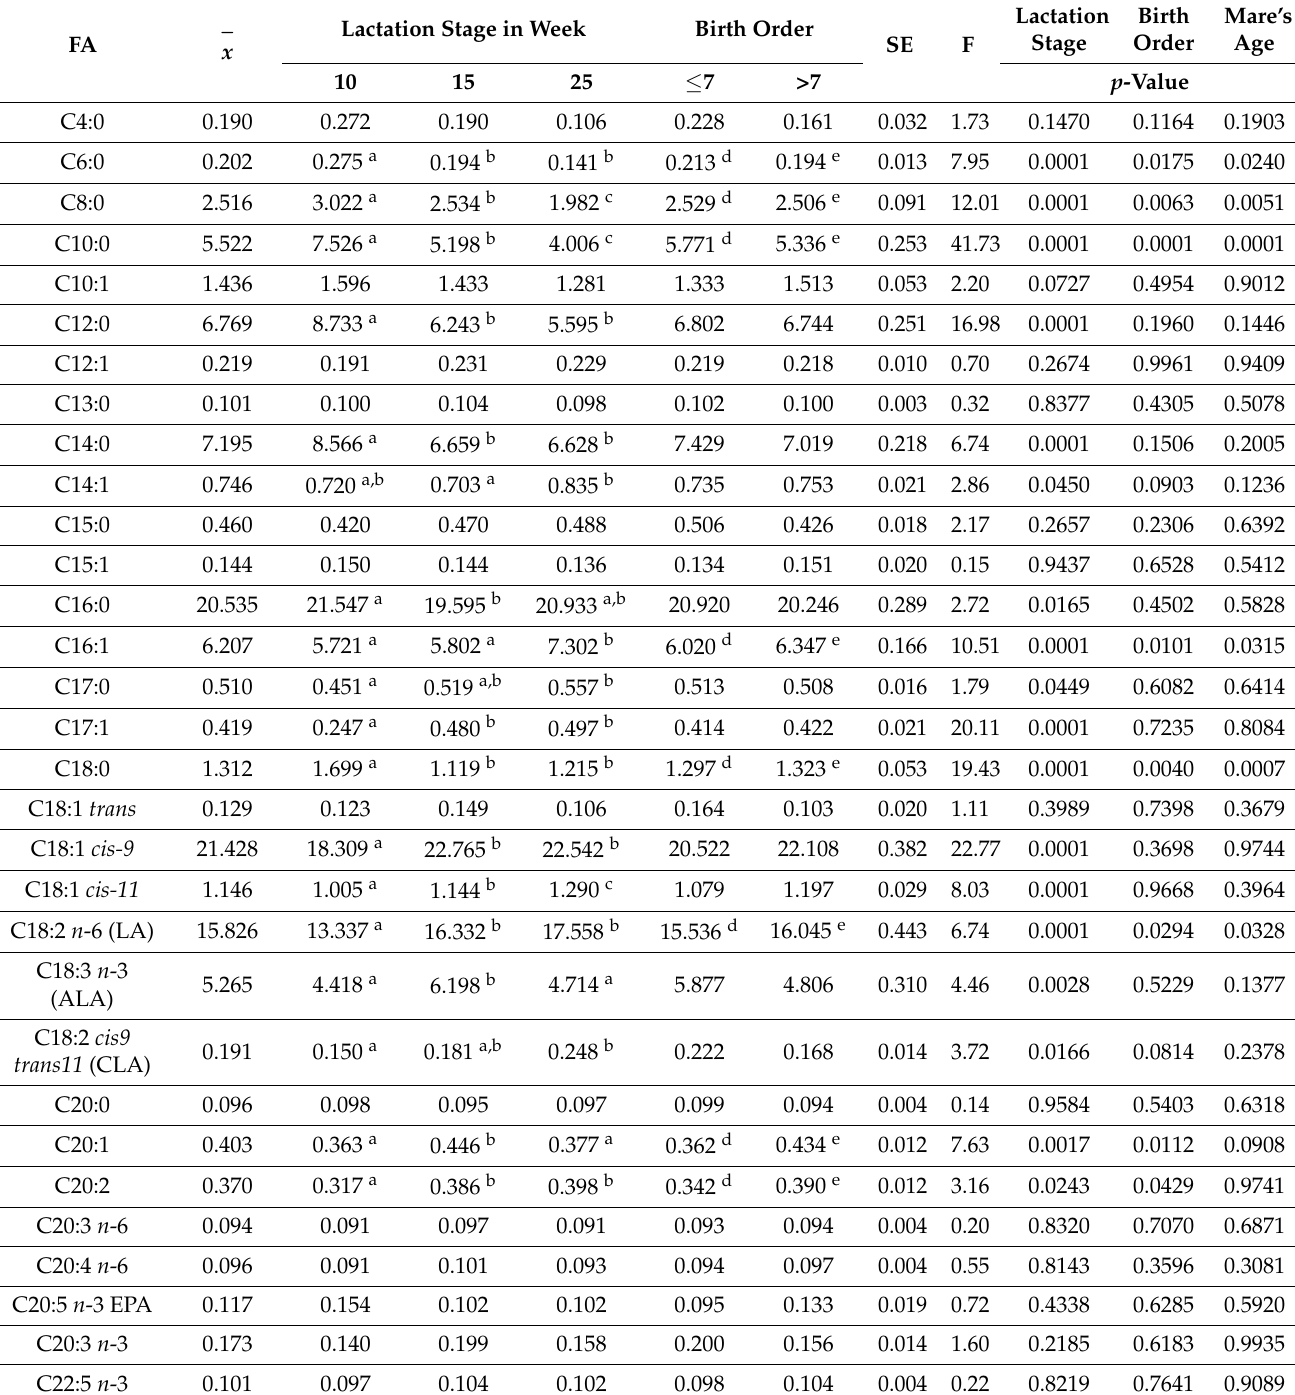
Table 2. Effect of lactation stage, birth order, and mares’ age on fatty acid profile of mare’s milk (g/100 g total fatty